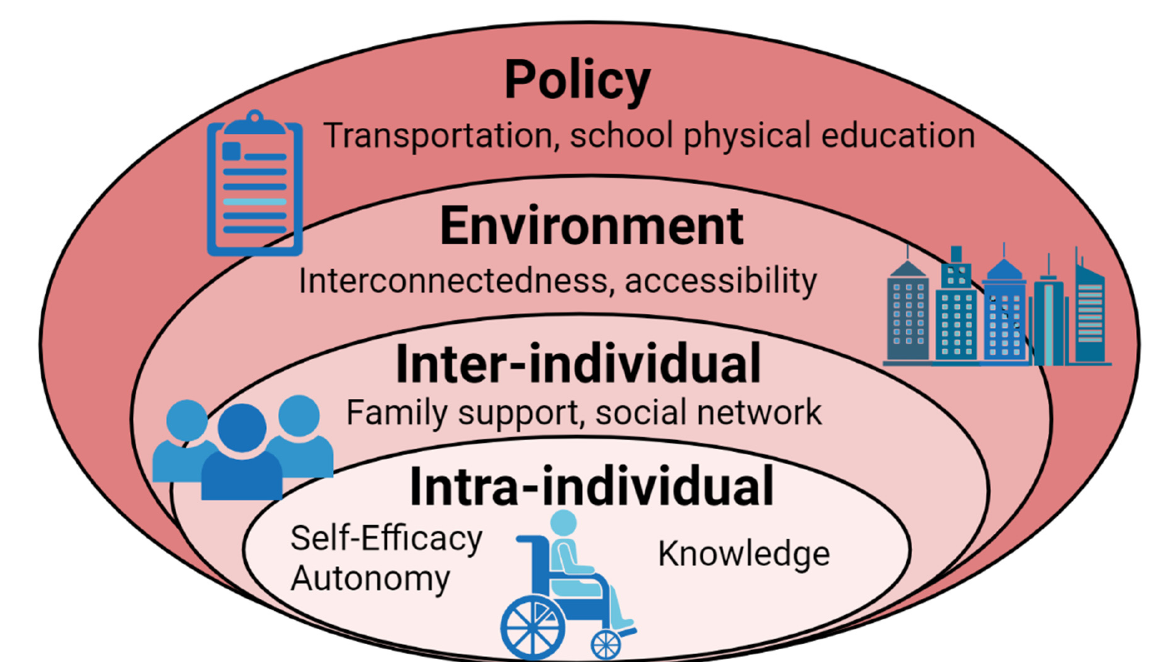
Figure 1. Influential factors on physical activity in youth wheelchair users: A socioecological approach.